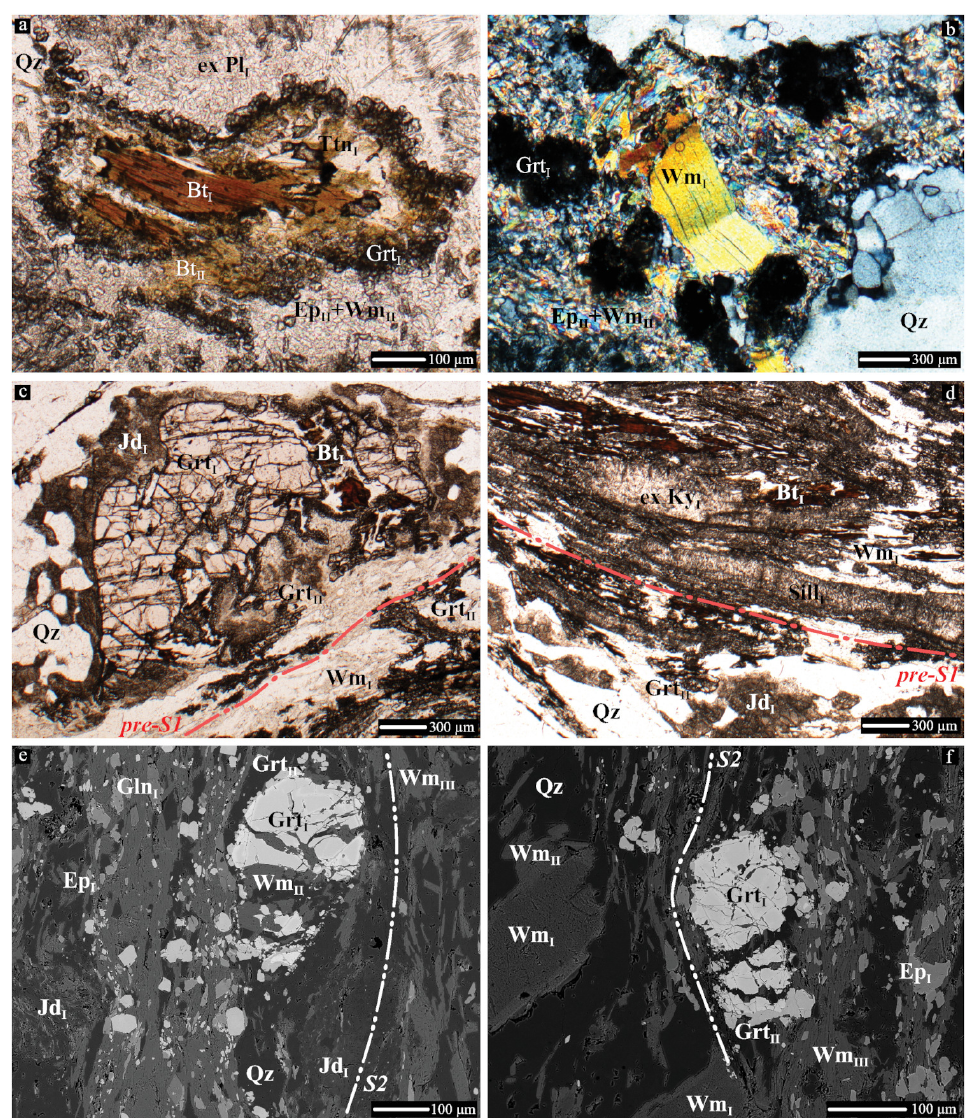
Figure 5. Detailed mineralogical assemblages at the microdomain scale for LdV, MM, and RCT investigated samples: ( a , b ) LdV micrographs of garnet corona (Grt I ) defining the primary boundaries between igneous biotite (Bt I ) and ex-PlI domain ( a -plane polarised light) and rimming relict white mica ( b -crossed polars); ( c , d ) MM micrographs of microgarnet (Grt II ) and JdI grown around Grt I ( c -plane polarised light) and pre-Alpine Sil I and Pl microdomains ( d -plane polarised light); ( e , f ) RCT back-scattered electron images displaying Grt I rimmed by Grt II and S2 foliation marked by Gln I , Ep I , Jd I , and fine grained Wm III